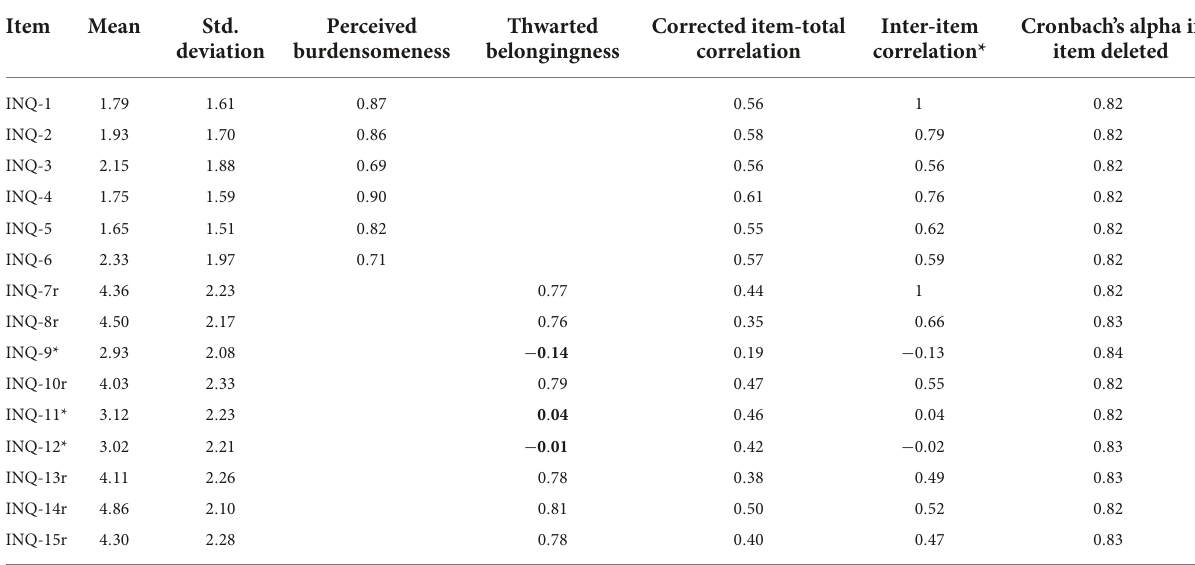
TABLE 2 Construct and factor loading of INQ-B ( n = 1,207).